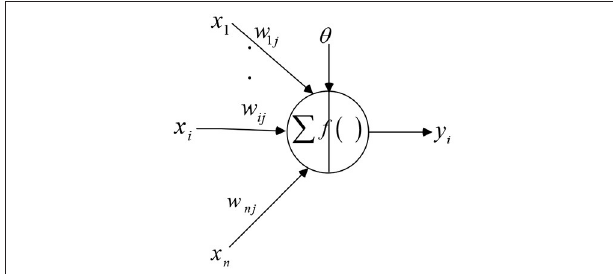
FIGURE 1 | Schematic diagram of BP neuron model.